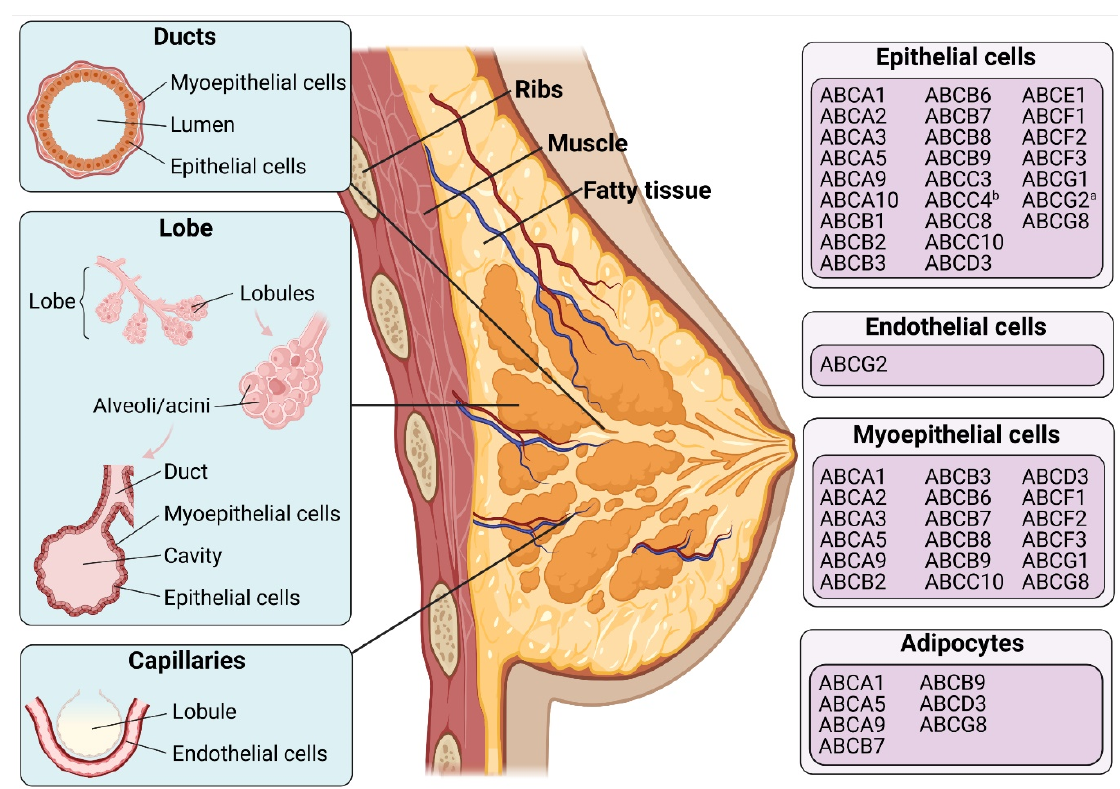
Figure 2. Distribution of ABC proteins in human mammary glands. “a” indicates the apical membrane, and “b” indicates the basolateral membrane. Data were extracted from The Human Protein Atlas database (http://www.proteinatlas.org; Last access date: 1 March 2021) and references [20–23]. Figures were created with BioRender.com (accessed on 22 March